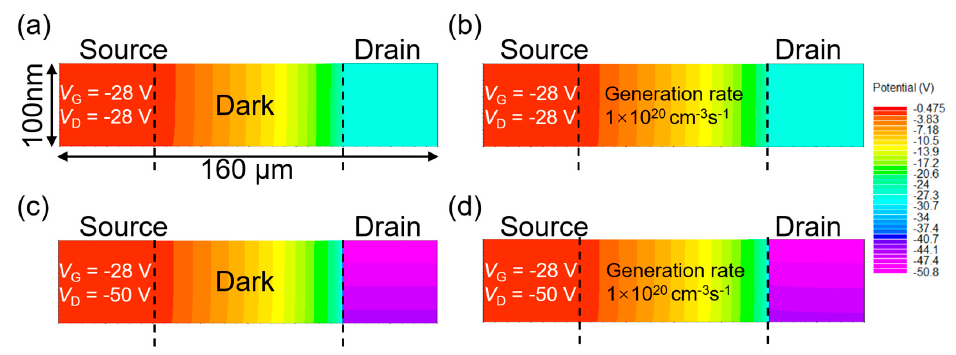
Figure 5. Surface potential mapping in the channel under different bias conditions ( V G = − 28 V and V D = − 28 V for ( a , b ); V G = − 28 V and V D = − 50 V for ( c , d )) and illumination conditions (Generation rate = 0 for ( a , c ); Generation rate = 1 × 10 21 cm − 3 s − 1 for ( b , d )).